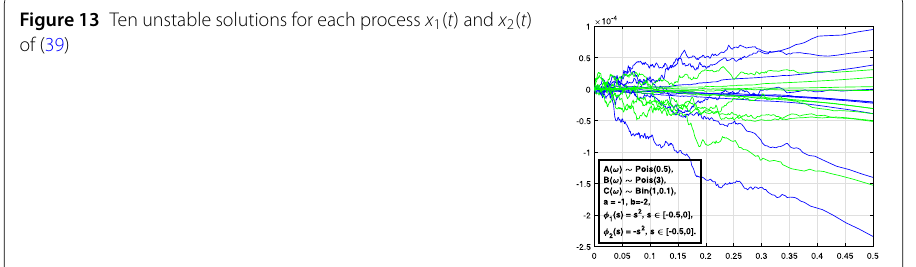
Figure 13 Ten unstable solutions for each process x 1 ( t ) and x 2 ( t ) of (39)